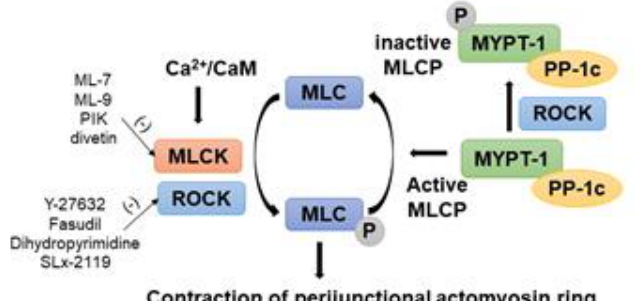
Figure 2. Regulation of phosphorylation of myosin light chain-2 (MLC-2) by myosin light chain kinase (MLCK)/Rho-associated coiled coil containing protein kinase (ROCK) to regulate AJC barrier in intestinal epithelial cells. Paracellular permeability is principally determined by the phosphorylation level of the regulatory light chain of myosin, MLC-2, which is regulated by the enzymes MLCK and ROCK. Increased intracellular Ca 2+ levels stimulate MLCK activity, which directly phosphorylates MLC-2. Enhanced ROCK activity also directly phosphorylates MLC-2 and inhibits MCL phosphatase (MLCP) activity by phosphorylating the myosin phosphatase target subunit 1 (MYPT1). There are pharmaceutical inhibitors for MLCK and ROCK